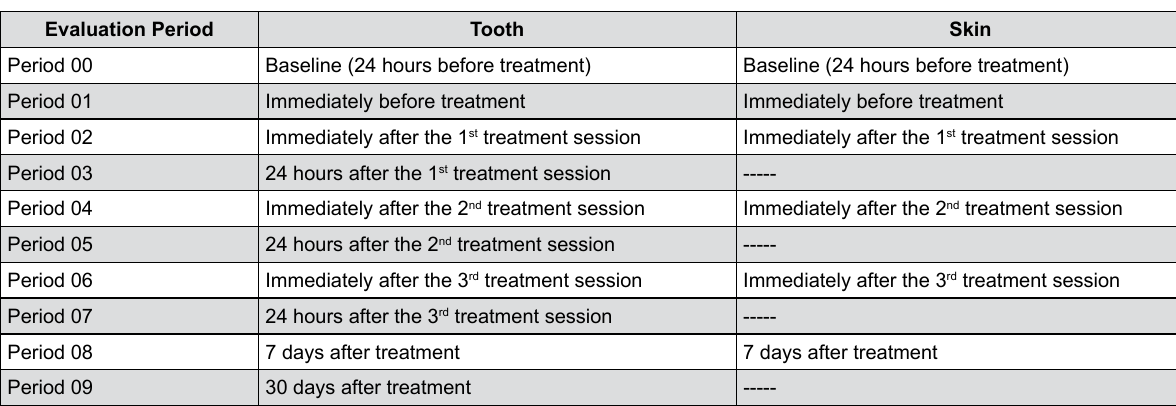
Figure 3- Evaluation periods of the skin and dental cold sensation threshold